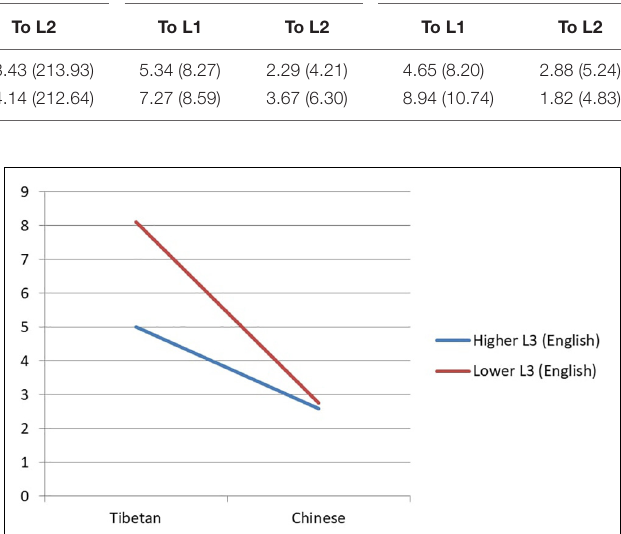
FIGURE 2 | The interaction between language and the non-task language proficiency in ERs in Experiment